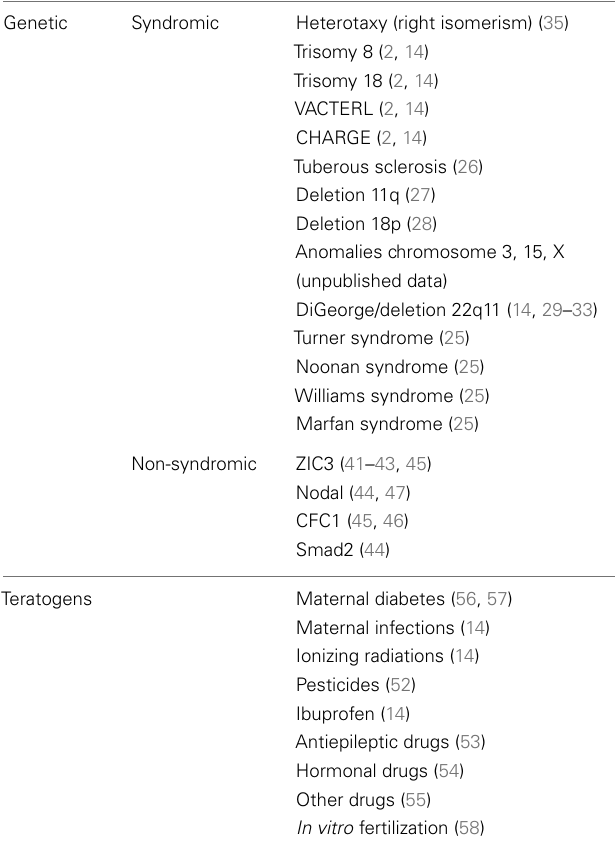
Table 1 | Genetic and non-genetic causes ofTGA.